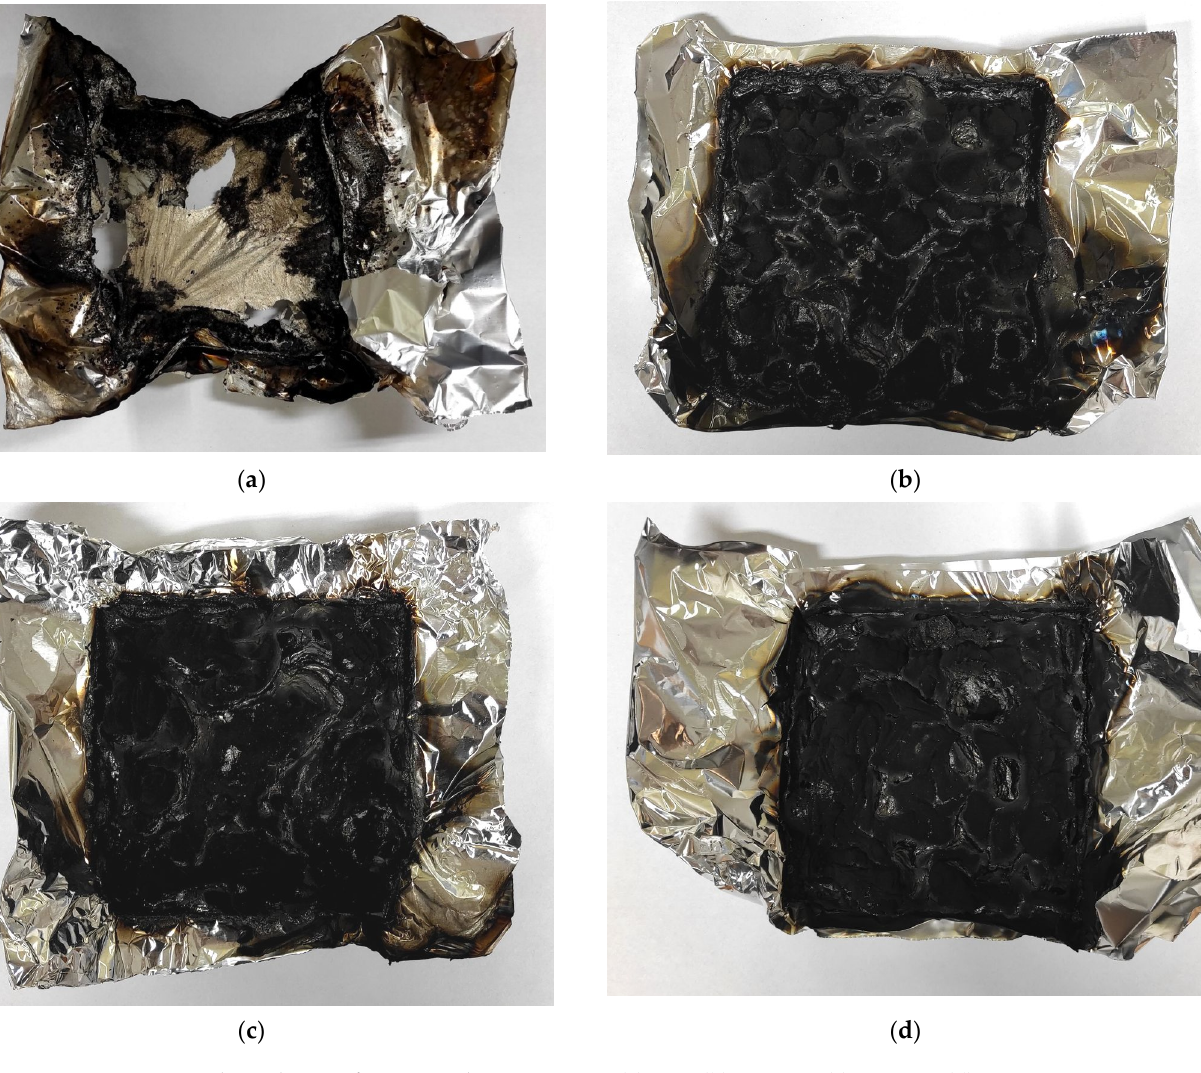
Figure 8. Polyurethanes after cone calorimeter tests: ( a ) REF, ( b ) FPU-8.5, ( c ) FPU-9.0, ( d ) FPU-9.5.